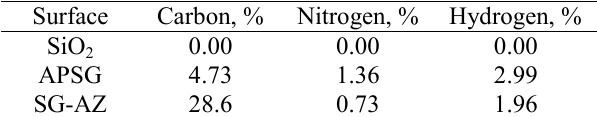
Table 1. Percentages (%) of carbon (C), hydrogen (H) and nitrogen (N) for the matrices SiO , APSG, and 2